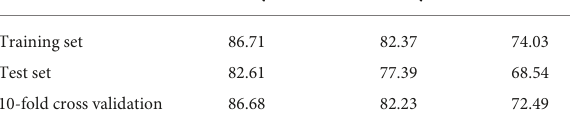
TABLE 2 Evaluation index analysis of the Bayesian forecasting model using different numbers of